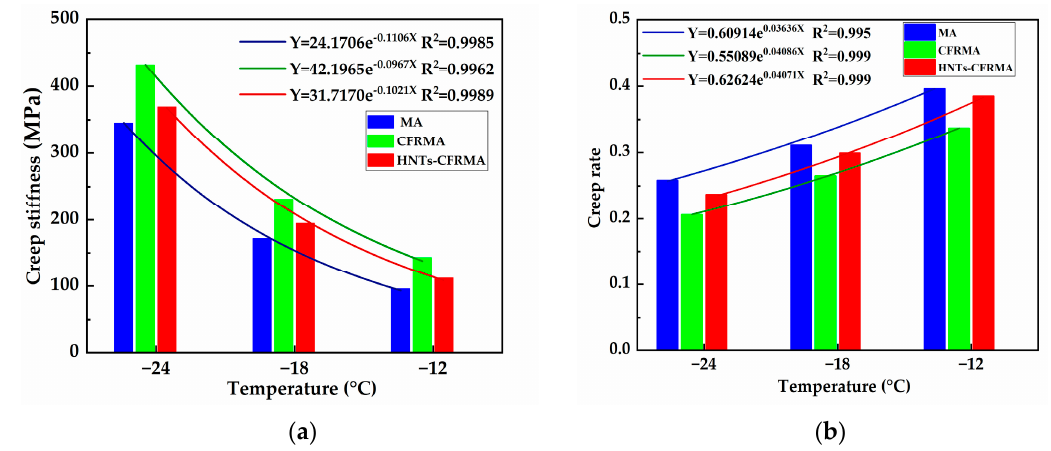
Figure 10. Variation law of asphalt creep characteristic parameters at low temperature: ( a ) Creep stiffness (S); and ( b ) Creep rate (m). Table 11. Characteristic parameters of asphalt creep at low temperature.